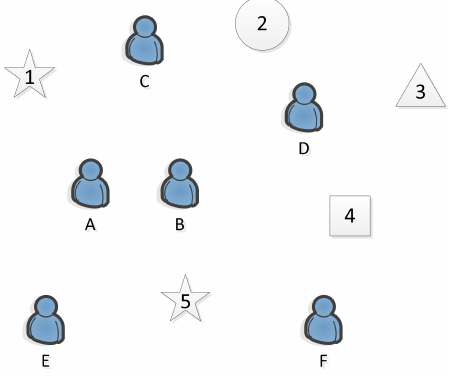
Figure 1. An Example of workers and